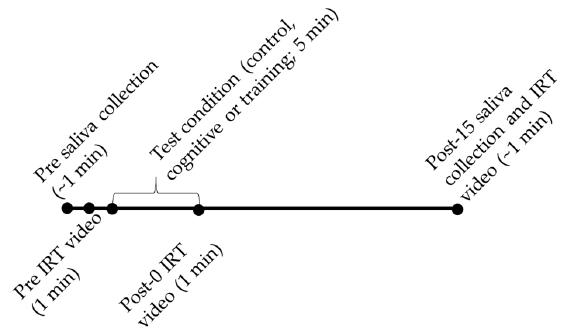
Figure 1. Timeline for data collection.